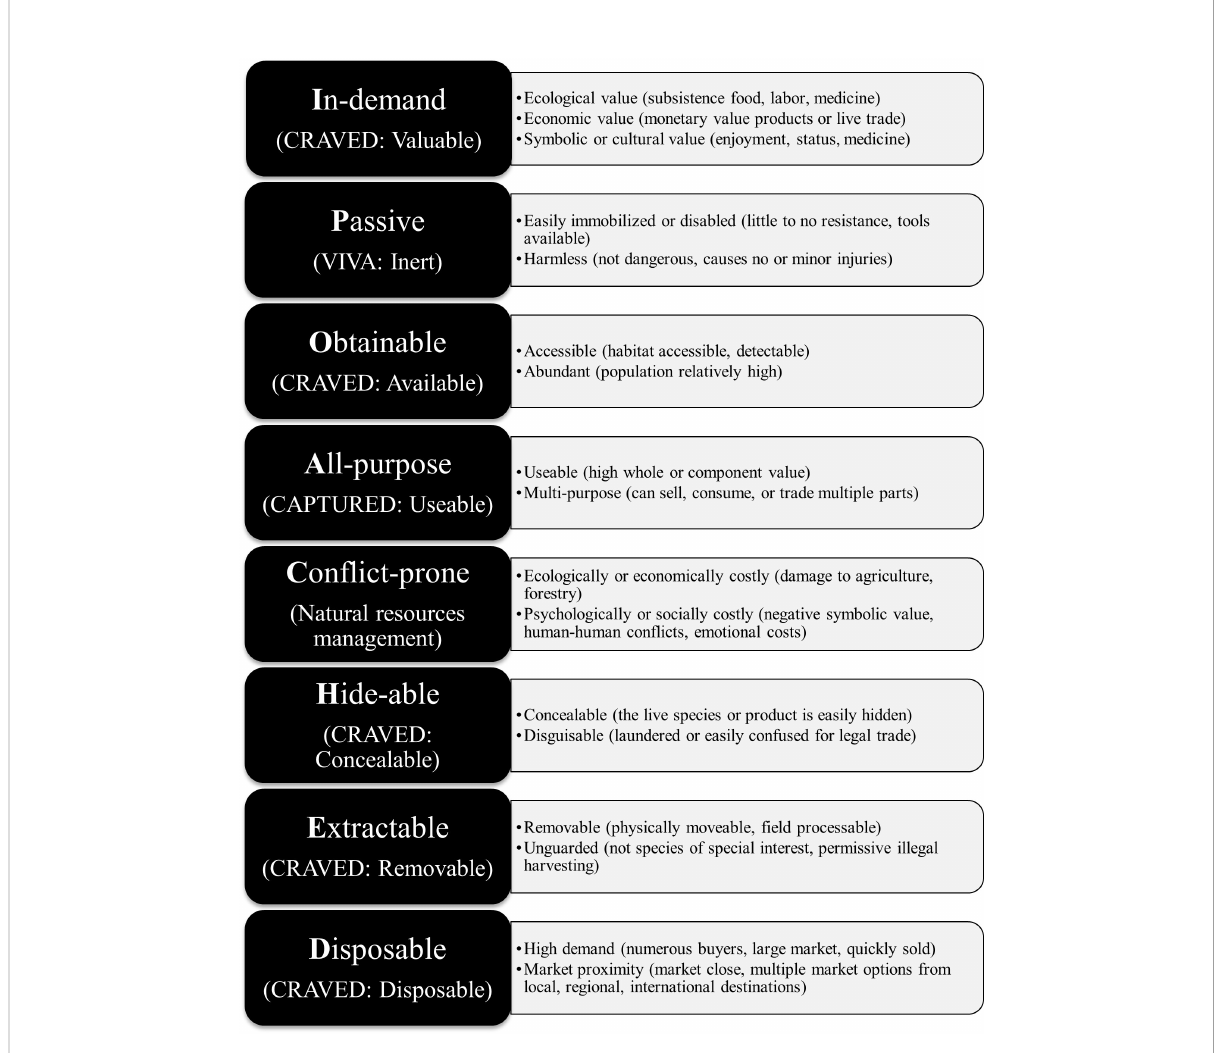
FIGURE 2 Empirically supported elements of the IPOACHED poaching-stage area-focused (PSAF)